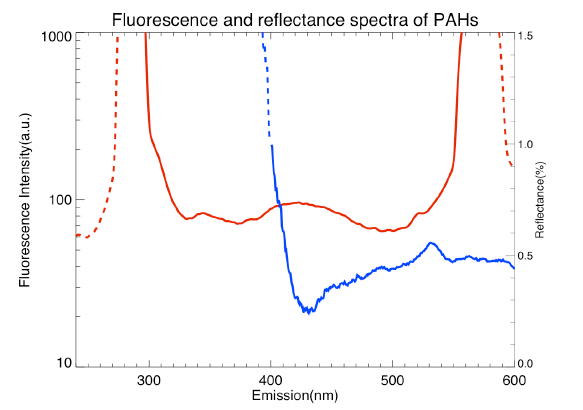
Figure 4. Fluorescence and reflectance spectra of PAHs, the first y-axis on the left hand side of the plot corresponds to the red line, and the second y-axis on the right hand side corresponds to the blue line. The red solid line exhibits the fluorescence emission of PAHs using excitation at a wavelength of 285 nm. The blue solid line shows the reflectance from the same sample that is illuminated by a Solux light source. The blue dashed curve is a noise signal due to the poor capability of the spectrometer to measure reflectance in the UV region. In order to examine the reflectance features of different crude oil samples, the spectral reflectance measurements were performed. Due to the large noise component in the UV region, reflectance data are only shown from 400 nm up to the near infrared (NIR); see figure 5.